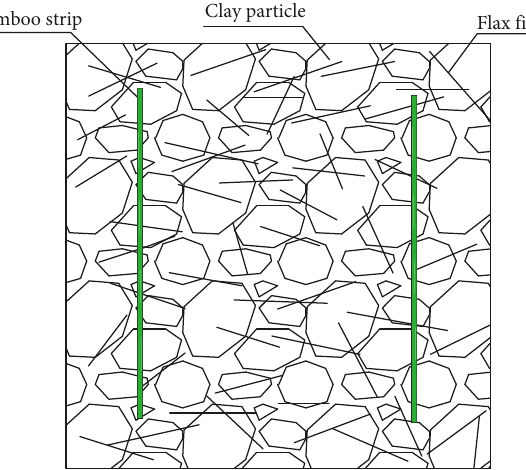
Figure 10: The reinforcement schematic diagram of the bamboo strips and flax fiber-reinforced clay (BFRC).